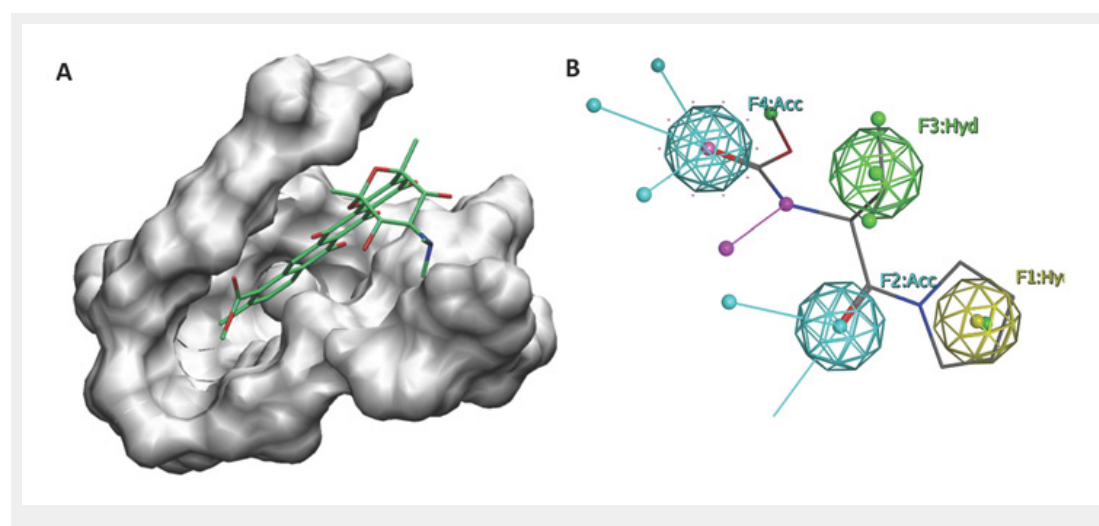
In-silico drug discovery strategies. (A) Virtual screening campaigns usually identify small molecules that fit within a particular pocket in a protein. (B) An illustration of a pharmacophore construction describing the distribution of important features for a drug that has three hydrophobic regions with two hydrogen bond acceptors. Based on these models virtual screens can be performed to focus only on a couple of interesting candidate compounds rather than screening a whole